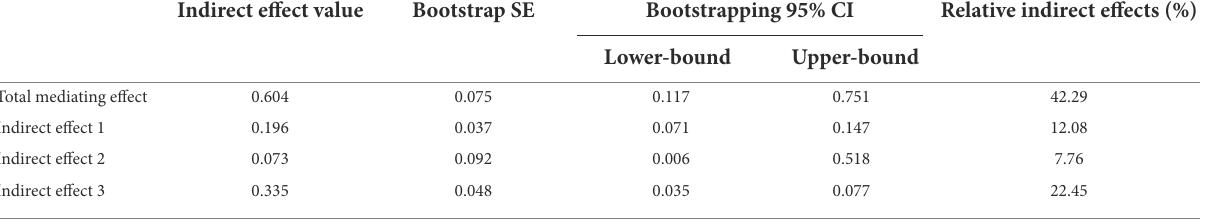
TABLE 7 Table of results of sequential mediated effects analysis.